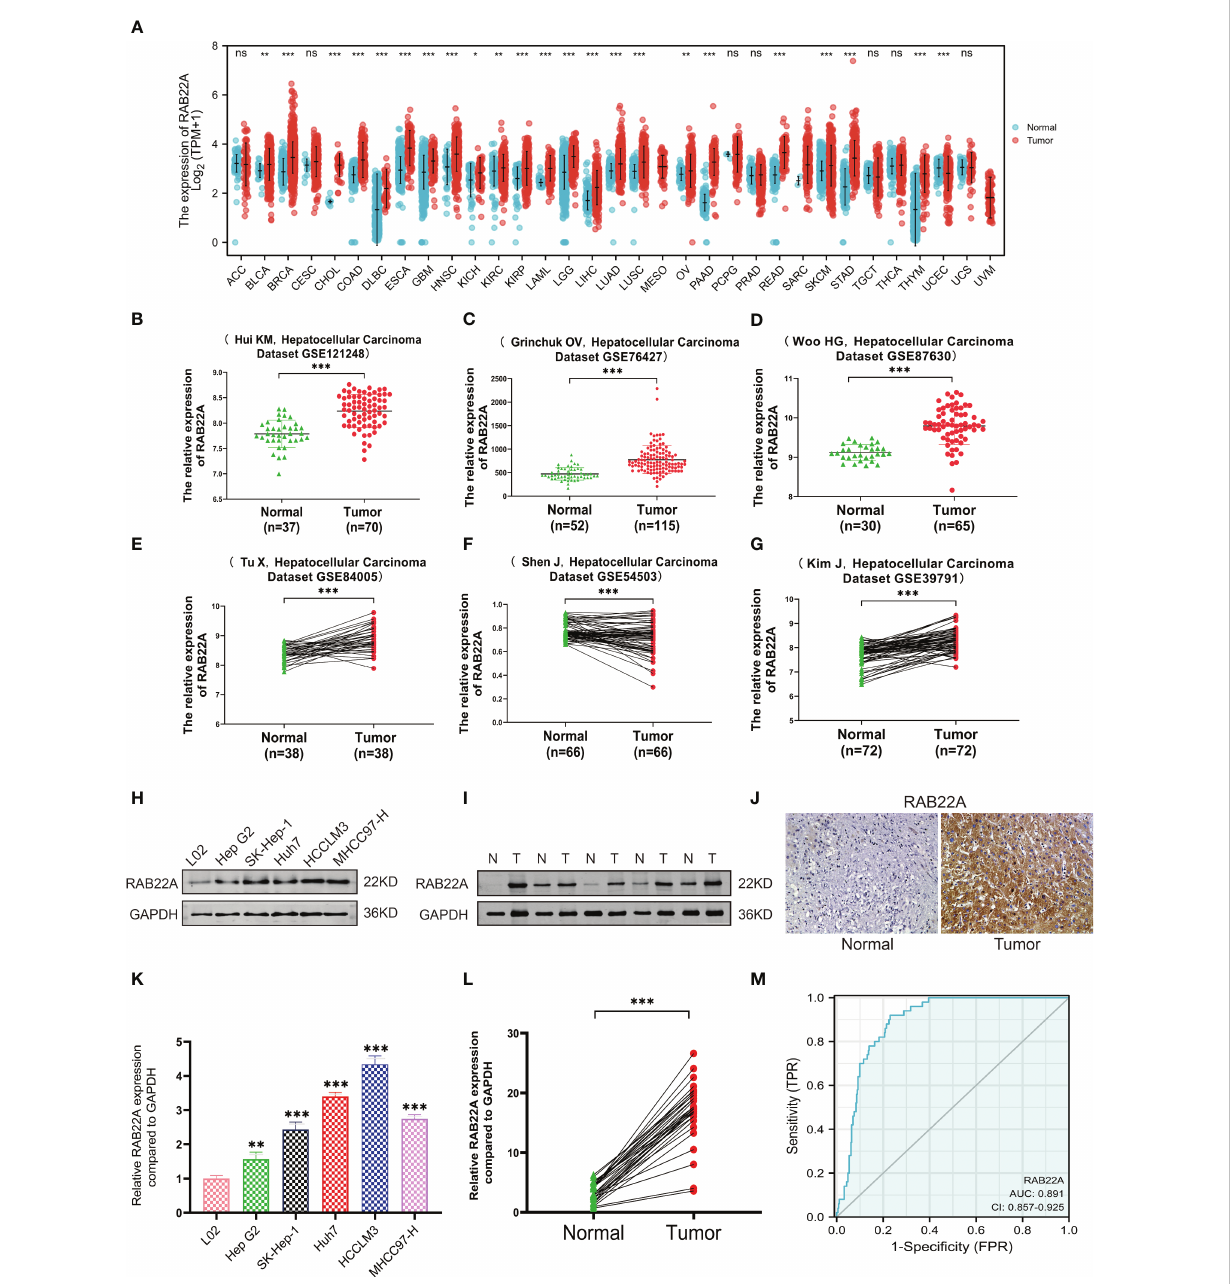
FIGURE 1 Expression level of RAB22A in HCC was veri fi ed in TCGA and GEO databases and in vitro experiments. (A) Comparison of the expression levels of RAB22A in different cancerous and normal tissues. (B – G) CEO database analysis of RAB22A expression in HCC tissues. (H) Western blotting assay of RAB22A protein expression levels in L02, Hep G2, SK-Hep1, Huh7, HCCLM3, and MHCC97-H cell lines. (I) Western blotting assay of RAB22A protein expression levels in HCC and adjacent tissues. (J) RAB22A protein levels in normal liver and HCC were measured using IHC. (K) qRT-PCR assay of RAB22A mRNA expression levels in L02, Hep G2, SK-Hep1, Huh7, HCCLM3, and HCCH97-H cell lines. (L) qRT-PCR assay of RAB22A mRNA expression levels in 30 pairs of HCC and adjacent tissues. (M) ROC curves were created to investigate the value of RAB22A in identifying HCC tissues. * p < 0.05, ** p < 0.01, *** p < 0.001, NS, no signi fi